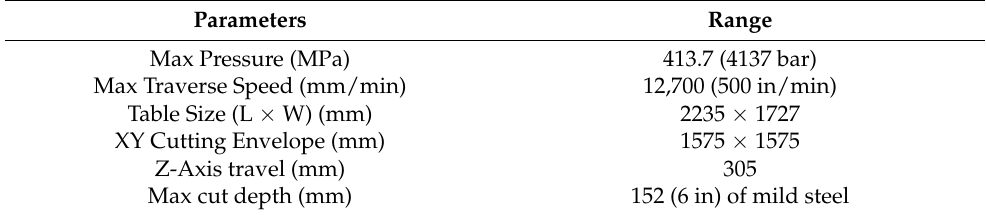
Table 2. Abrasive Waterjet Machine MAXIEM 1515 (OMAX Corp., Kent, WA, USA)